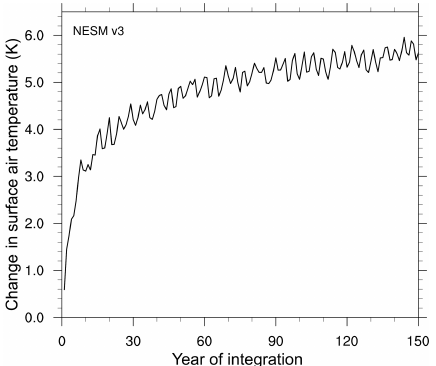
Figure 14. Results from the abrupt quadrupling of CO 2 experiment. Global mean surface air temperature change relative to the counter- part in the PI experiment.